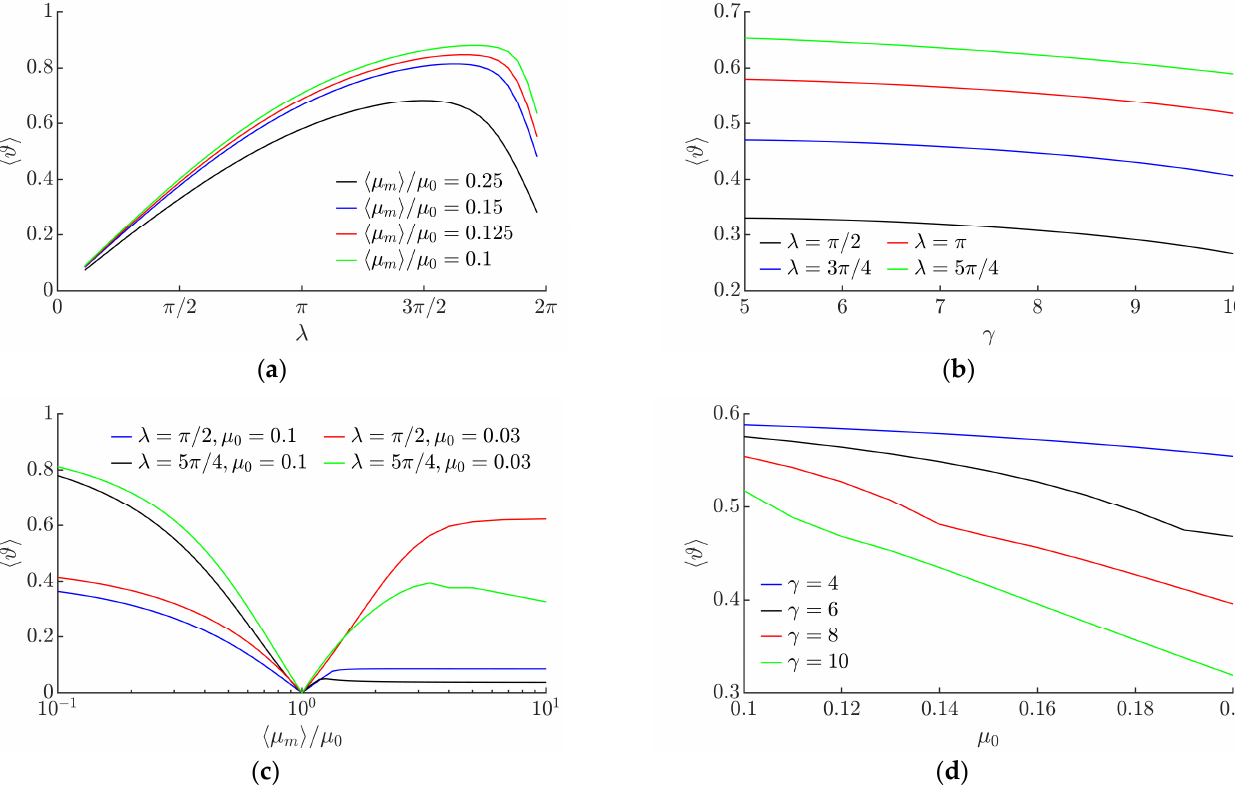
Figure 8. Average nondimensional velocity depending on the following: ( a ) λ when μ 0 = 0.1, γ = 5, ϕ = 0; ( b ) γ when μ 0 = 0.1, ϕ = 0, ⟨ μ m ⟩ / μ 0 = 0.25; ( c ) ⟨ μ m ⟩ / μ 0 when γ = 9, ϕ = π /2; ( d ) μ 0 when ⟨ μ m ⟩ / μ 0 = φ = 0; ( b ) γ when µ 0 = 0.1, φ = 0, 〈 µ m 〉 / µ 0 = 0.25; ( c ) 〈 µ m 〉 / µ 0 when γ = 9, φ = π /2; ( d ) µ 0 when 0.25, ϕ = 0, λ = π /2. 〈 µ 〉 / µ m 0 = 0.25, φ = 0, λ = π